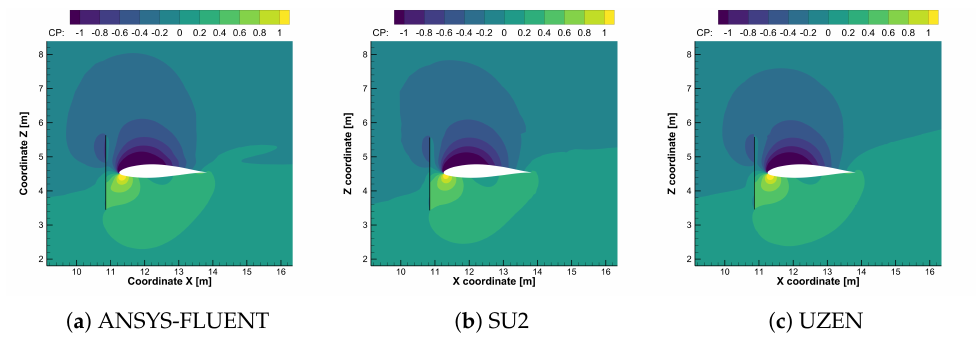
Figure 23. Pressure coefficient contour for power-on condition at α = 8 ◦